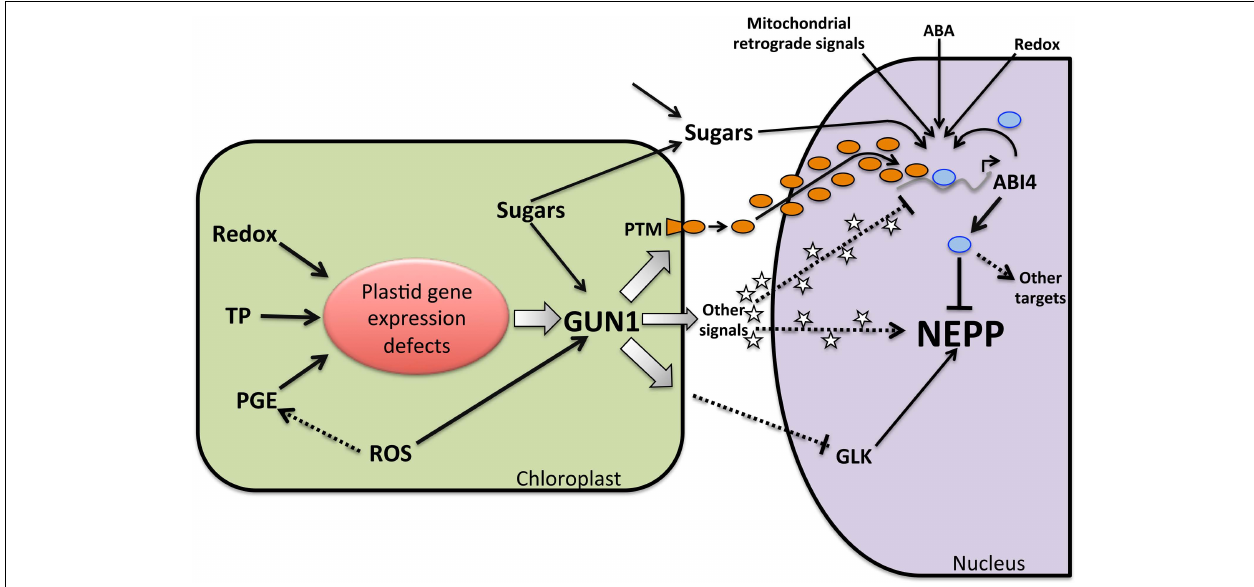
FIGURE 3 | Model of GUN1 andABI4 function as integrators of NEPP regulation from several retrograde signaling pathways. Multiple conditions that alter plastid functionality, such as inhibition of plastid transcription or translation (PGE), tetrapyrrole biosynthesis inhibition (TB), altered redox status (Redox), and ROS production, result in defects in plastid gene expression.This model demonstrates how defects in plastid gene expression are capable of producing multiple signals, in close cooperation with GUN1, which acts as a convergent node.These signals can be positive or negative, resulting in the processing of the PTM factor in the plastid envelope and allowing its translocation to the nucleus (black circles), for example. In parallel, positive signals like heme (stars) generated by the plastid under normal conditions will decrease (represented by a smaller arrow).These events will lead to an increase in the level of the transcriptional regulator ABI4